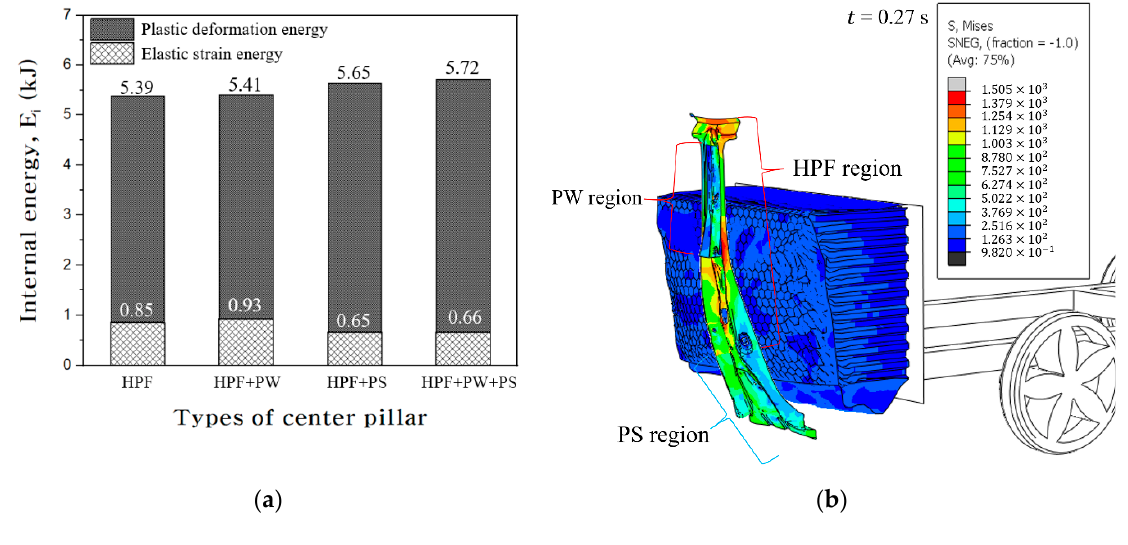
Figure 17. ( a ) Maximum internal energy ( E i ) for the four types of center pillar. ( b ) Stress distribution of the center pillar during collision.